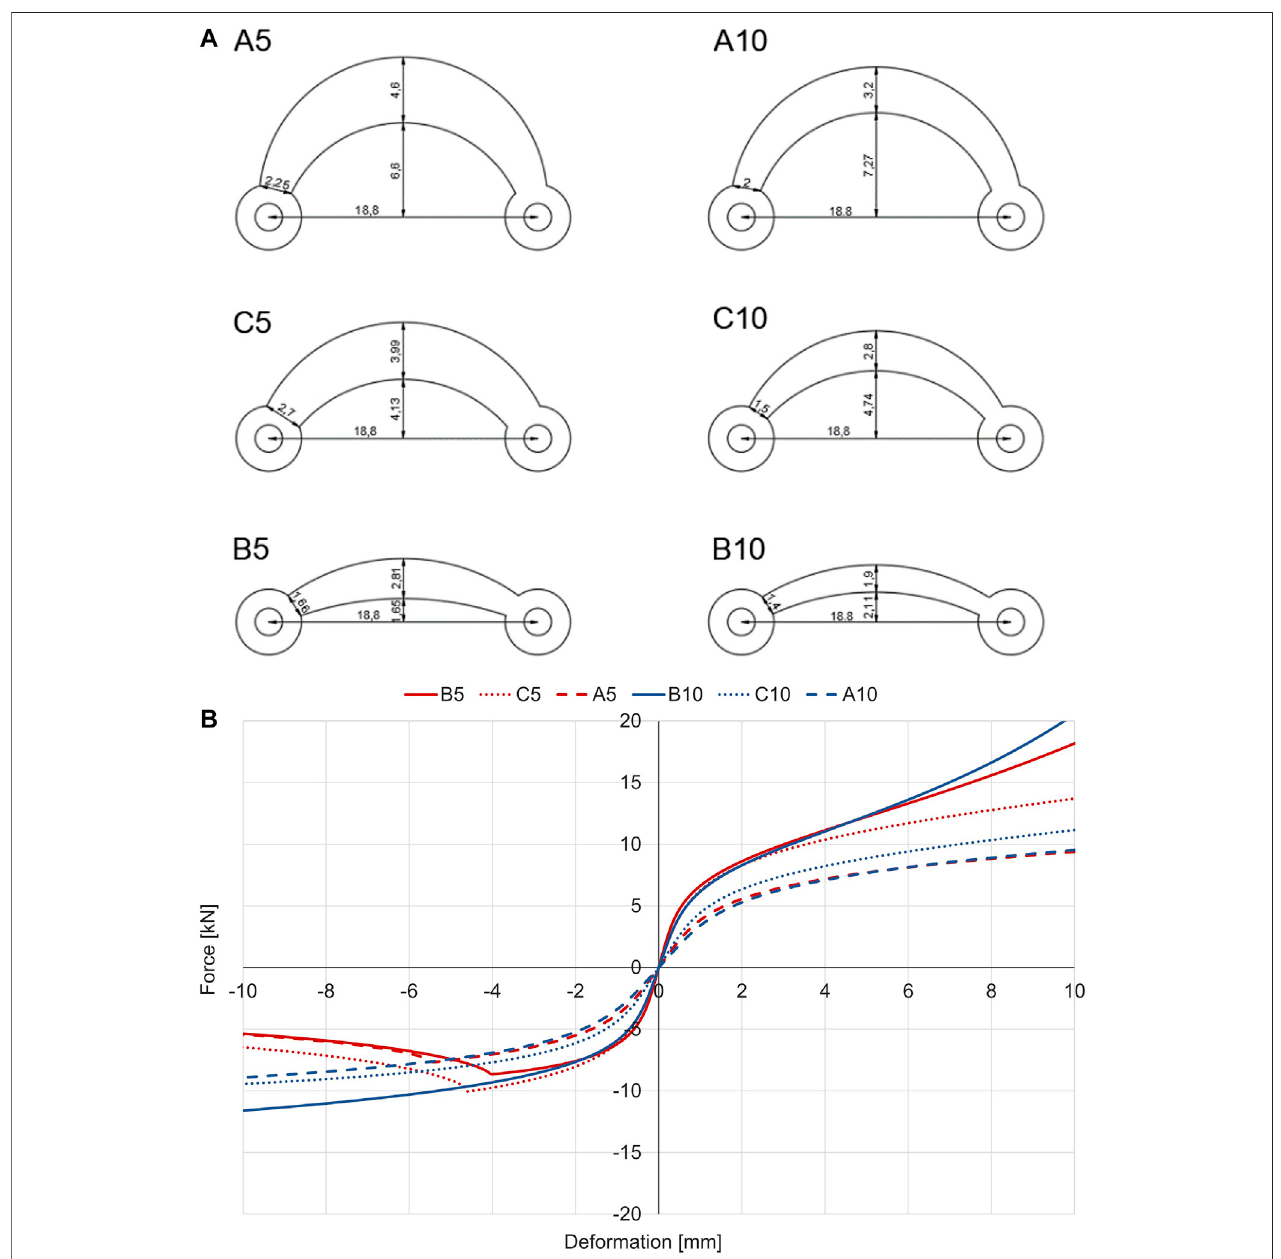
FIGURE 2 | Selected geometries of the device as a function of the curvature and the thickness (measures expressed in centimetres) (A) and results of the associatednon-linearstaticanalyses (B) .Note:consideringthedeviceid,theletterA,BorCindicatesthecurvatureofthedevicewhilethefollowingnumberindicatesthe thickness expressed in